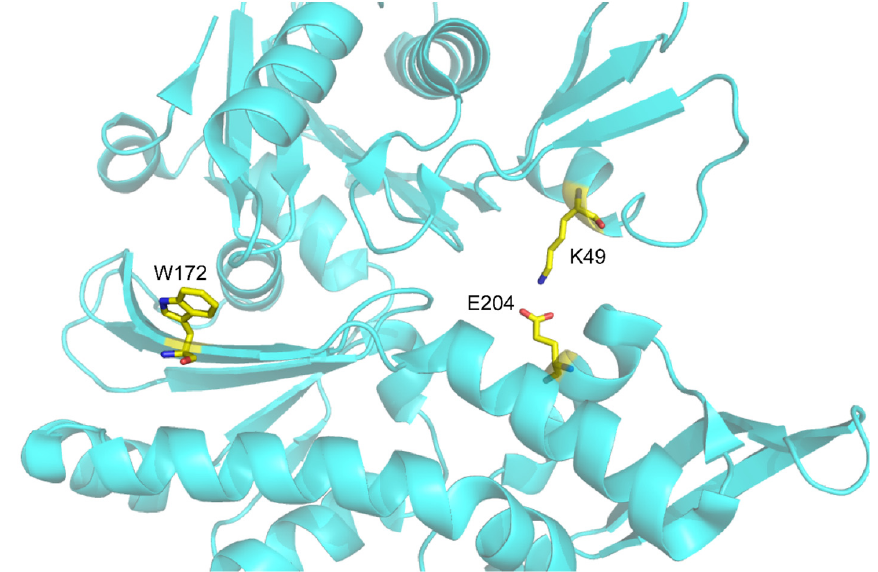
Figure 8. The salt bridge of Tm ‐ MreB can affect the conformation of Tm ‐ MreB and consequently the fluorescence emission of the tryptophan residue. Tm ‐ MreB (PDB: 1JCG) K49 lysine and E204 glutamic acids are located on different subdomains; therefore, the salt bridge between them may affect the local environment of W172.